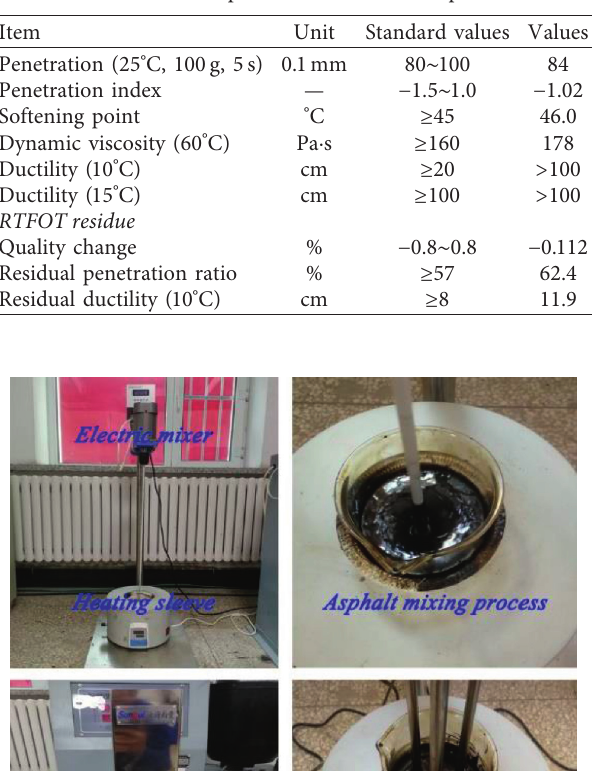
Table 1: Basic performances of neat asphalt.